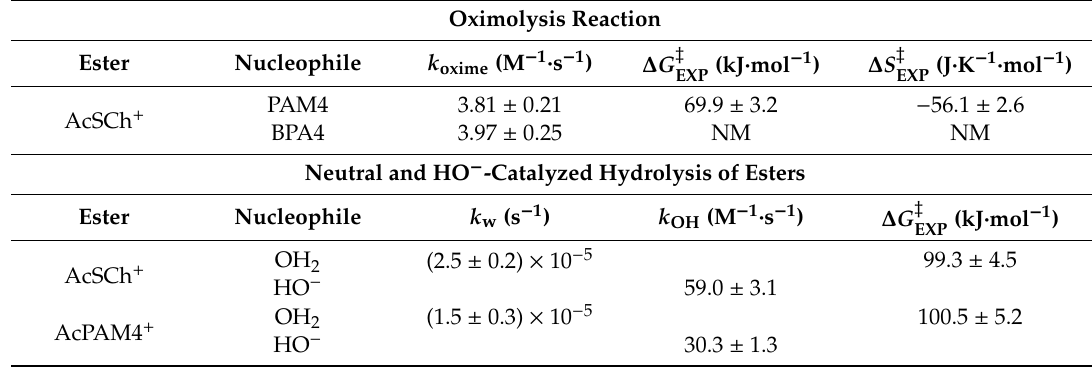
Table 1. Kinetic and activation parameters at 25 °C and I = 0.1 M.